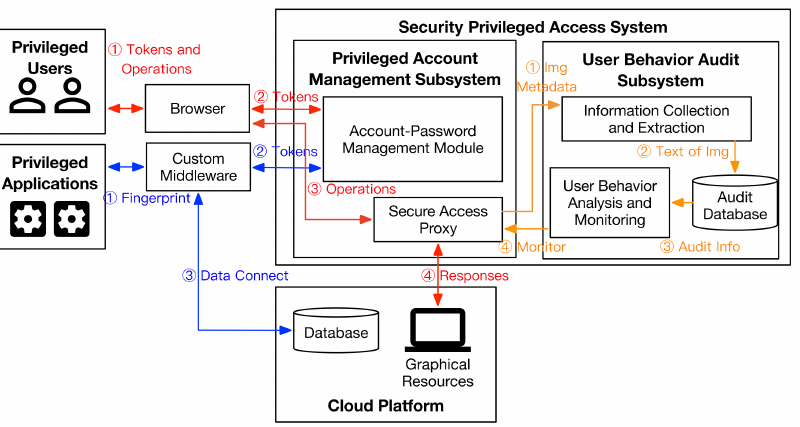
Figure 1. Overall structure of SA-UBA. The red line represents the user-access process, the blue line represents the application-access process, and the yellow line represents the user behavior audit process. Before users and applications access the system, all privileged accounts will be statistically stored and managed by the Accounts Password Management